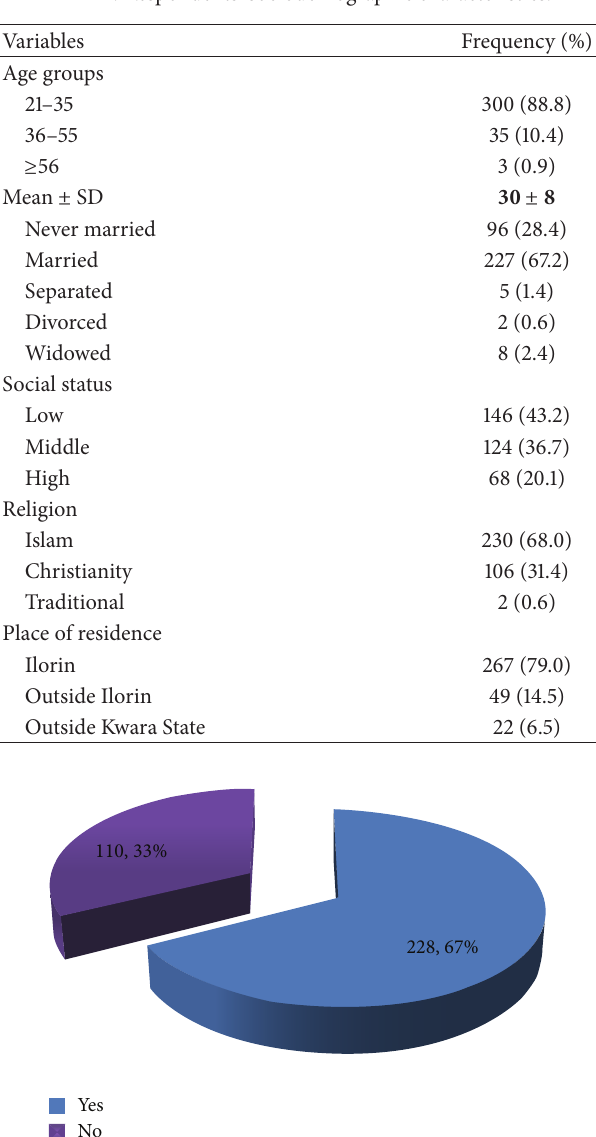
Table 1: Respondents’ sociodemographic characteristics.